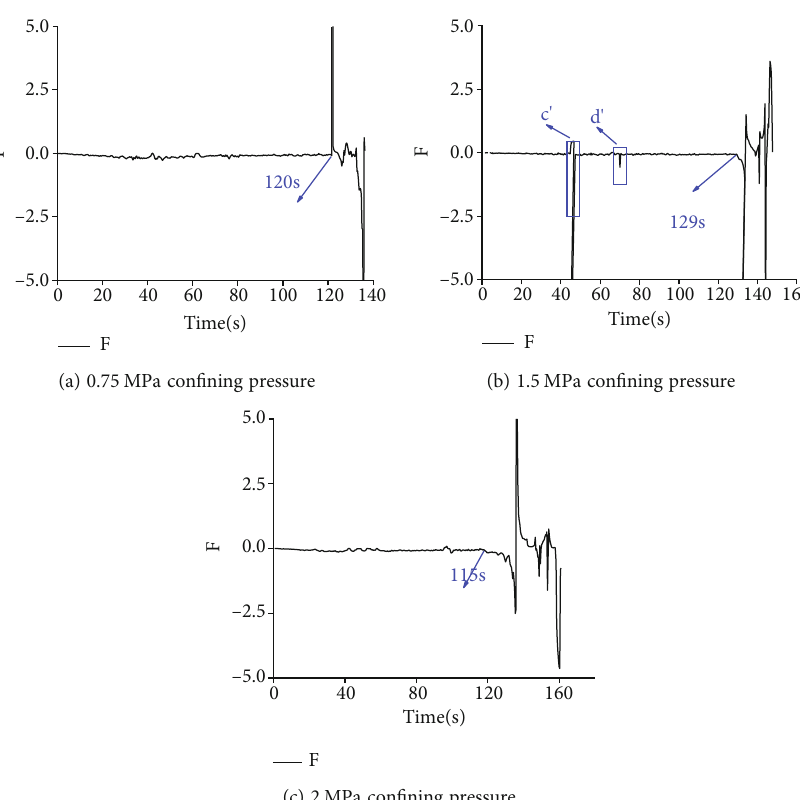
Figure 16: The variation curve of the F value under di ff erent con fi ning pressures.